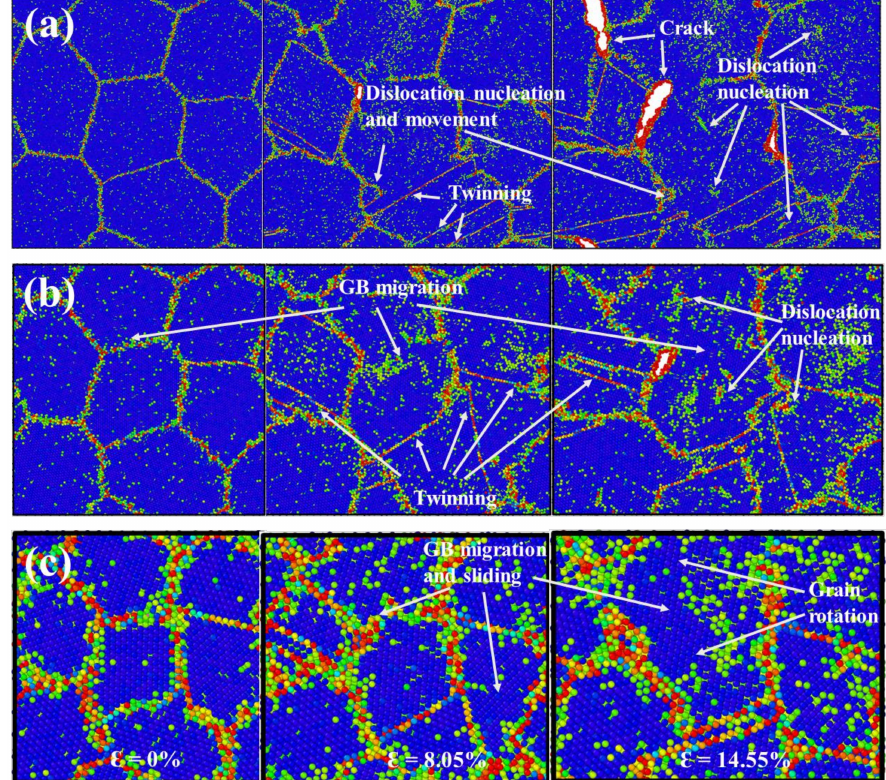
Figure 4. ( a – c ) The atomic snapshots of NG 18 , NG 10 and NG 6 at different tensile strains under tension, respectively. Images are colored by CSP, and various deformation mechanisms are indicated by